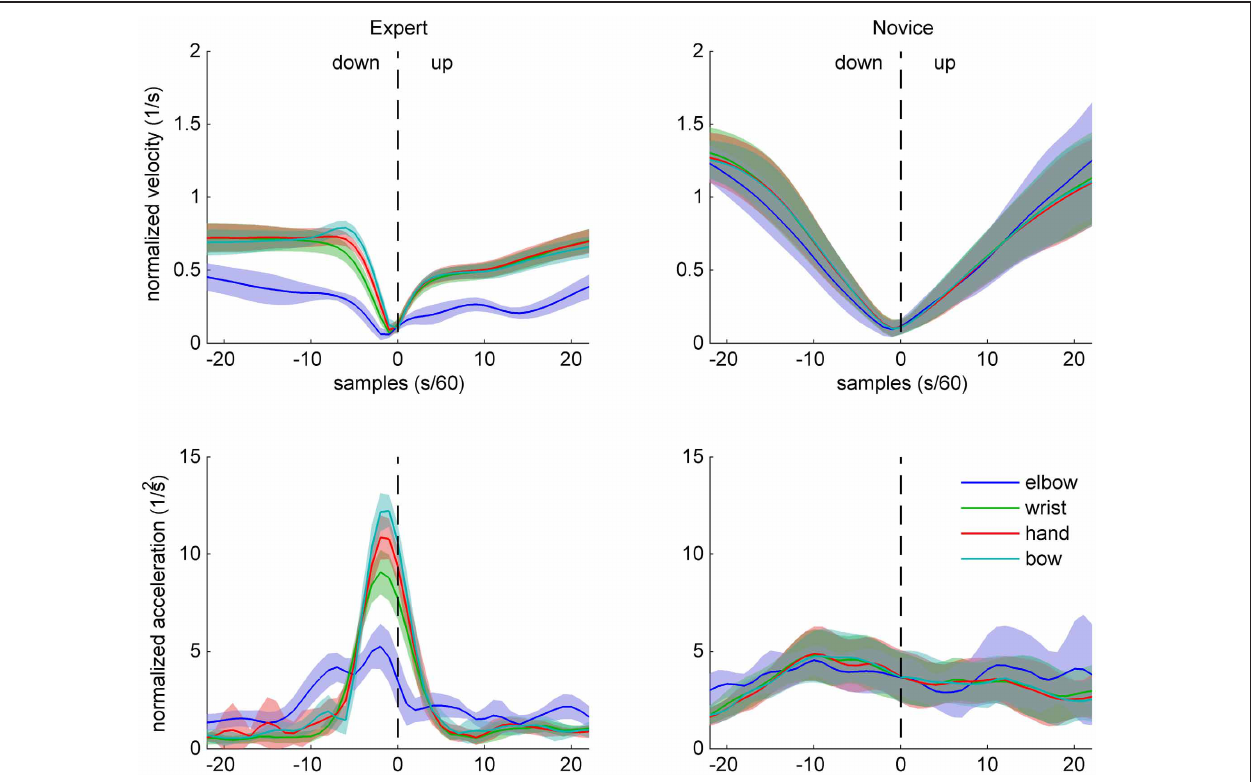
FIGURE 5 | Sample data of arm and bow kinematics (velocity and acceleration, normalized relative to the shoulder joint) for an expert (left) and a novice (right) cello player, during a down-up bow reversal. Shaded areas indicate SD across